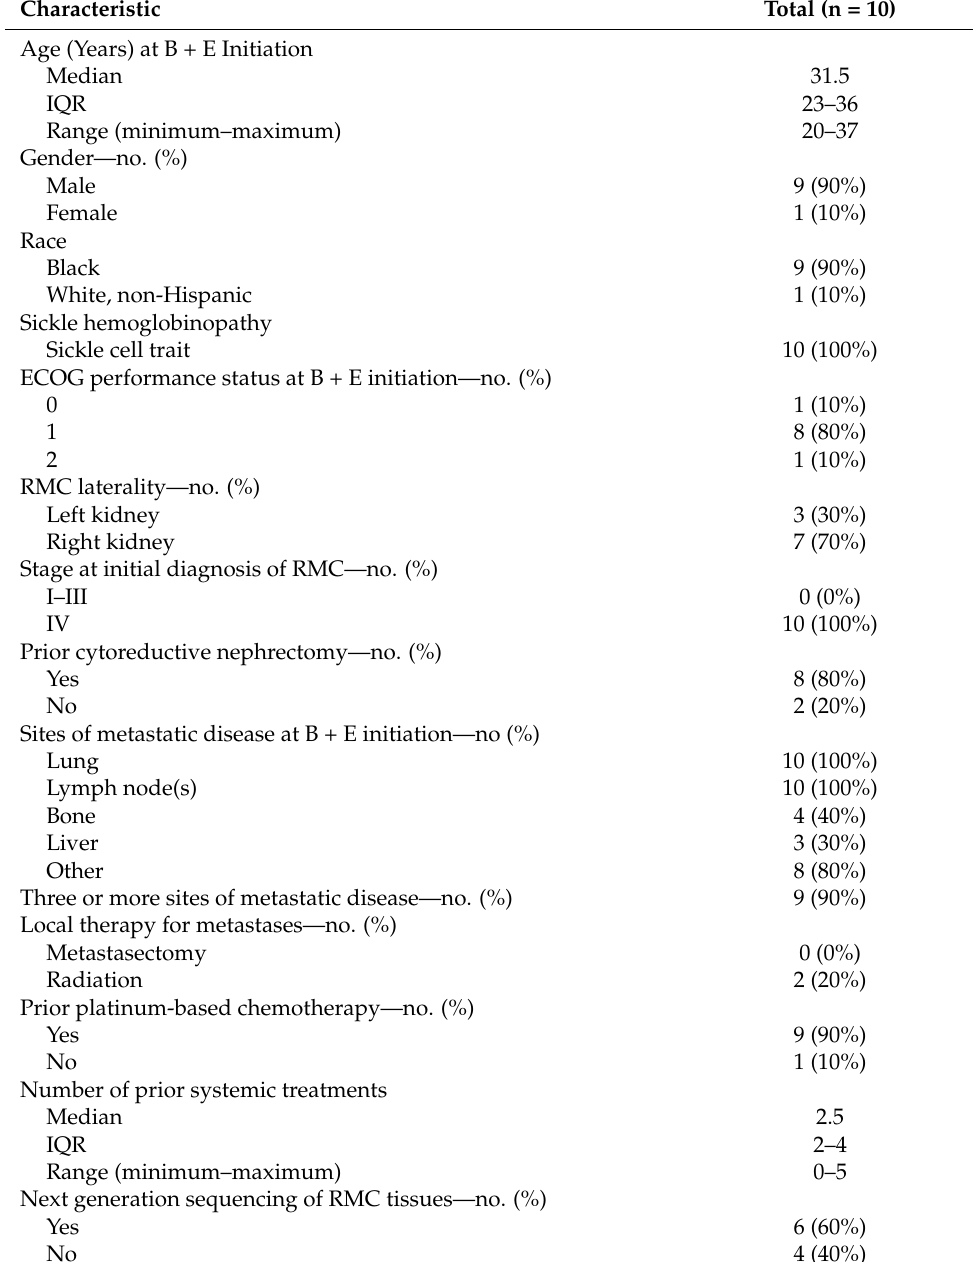
Table 1. Baseline demographics, clinical and prior treatment